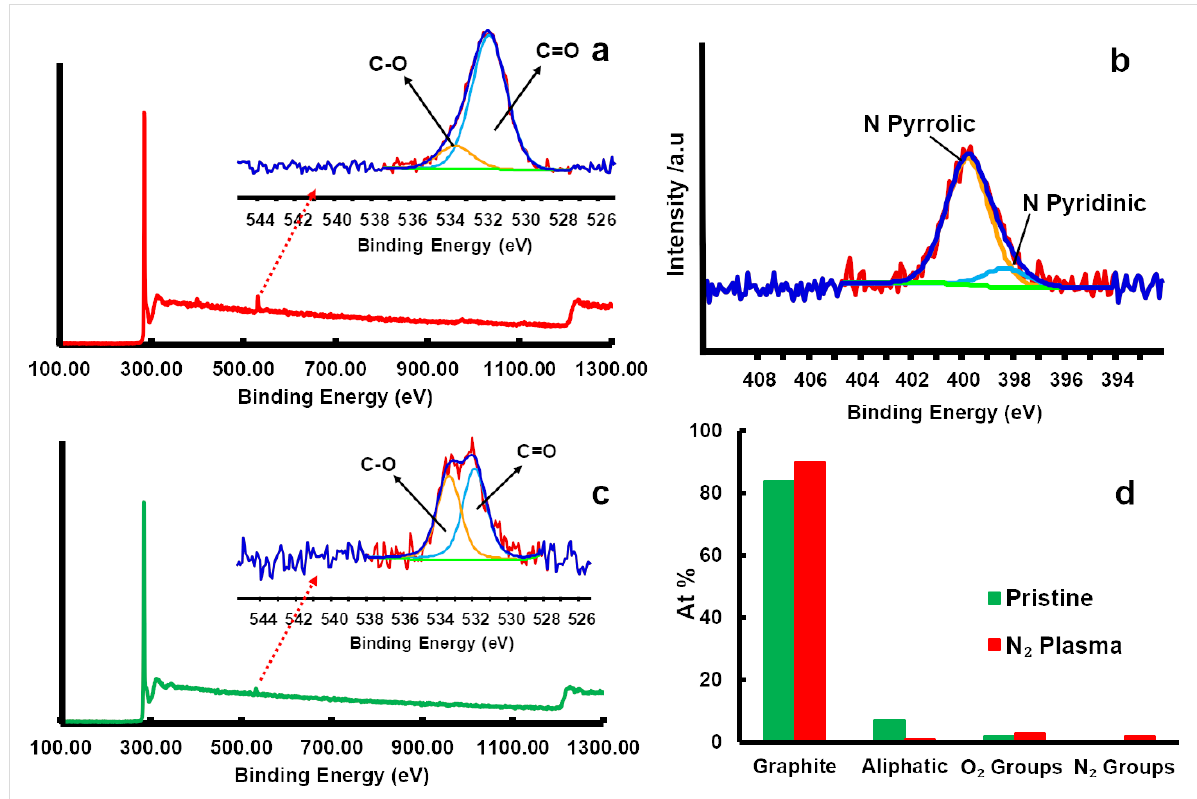
Figure 2: XPS results obtained for pristine and N 2 -plasma-treated samples. a) Survey scan for the N 2 -plasma-treated sample and inset showing the O 1s peak fitting results, b) N 1s peak fitting for the N 2 -plasma-treated sample, c) survey scan for the pristine sample and inset showing the O 1s peak fitting results, and d) composition of the various groups obtained after peak